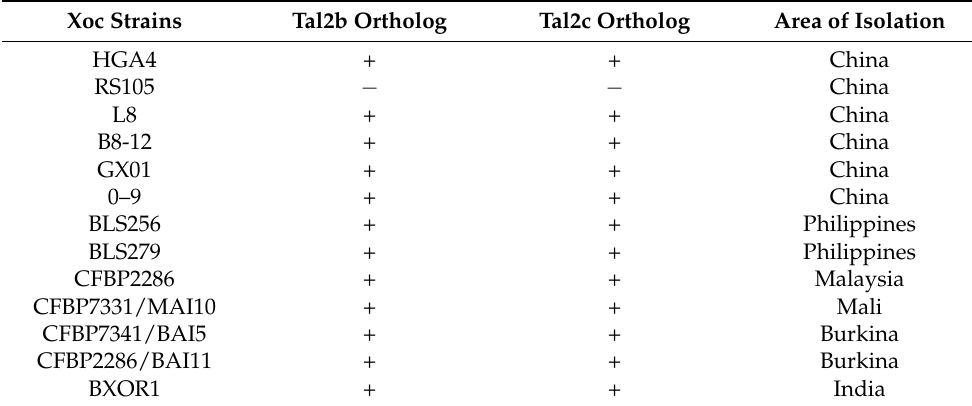
Figure 1. Tal2c from the Xoc strain HGA4 enhances the pathogenicity of Xoc strain RS105 by increasing the expression of OsF3H 04g . ( a ) Image of lesion expansion and ( b ) lesion length in ZH11 rice leaves after inoculation with RS105, RS105/Tal2c and HGA4 at 14 days. Data represent the means ± SD, n = 10. Asterisks represent significant differences between RS105 and RS105/Tal2c, RS105 and HGA4 (* p ≤ 0.05, ** p ≤ 0.01, Student’s t- test). ( c ) Relative expression of OsF3H 04g at 4 days post inoculation (dpi) with RS105, RS105/Tal2c and HGA4. The internal control was used, OsACTIN . Data represent the means ± SD, n = 3. ( d ) Bacterial populations and ( e ) relative bacterial biomass of RS105, RS105/Tal2c and HGA4 in ZH11 rice at 4 and 8 days after inoculation. Data represent the means ± SD, n = 3. Total genomic DNA of ZH11 rice inoculated with Xoc strains at 0 dpi was used as a control. Asterisks represent significant differences between RS105 and RS105/Tal2c, RS105 and HGA4 (* p ≤ 0.05, Student’s t -test). Table 1. The Tal2b and Tal2c orthologs appeared to be tandem pairs in most Xoc